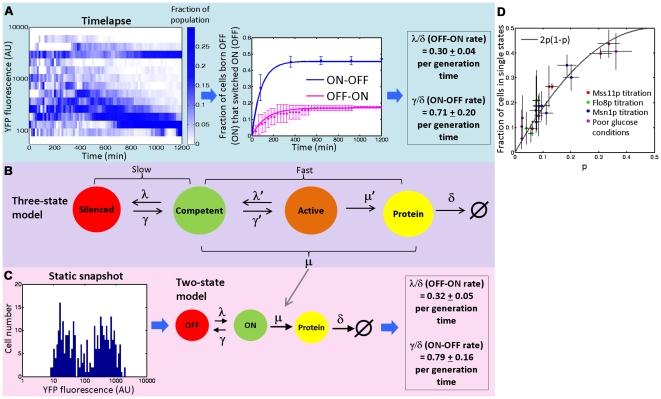
A method for inferring kinetics of switching from static steady state distribution.(A) (Left) Time evolution of the population distribution of YFP expression from a dual-reporter strain growing in YP 1% ethanol, 2% glycerol within a microfluidic chamber over 20 hours. Colorbar indicates fraction of cells (n = 230 over time course). This strain had been growing in identical conditions in liquid culture prior to transfer to the microfluidic chamber. The distribution changes early on because of the small initial sample size (n = 10). (Right) Marginal transition rates between ON and OFF states. Blue/pink dots indicate fraction of cells ON/OFF at birth and observed to switch OFF/ON. Corresponding curves are fits of the model for exponentially distributed switching times from ON to OFF and OFF to ON, with adjusted rates shown next to the plot. Error bars correspond to 3 s.d. from the mean calculated by a bootstrap analysis. Similar results are obtained when focusing on CFP expression (see Figure S5 and Figure S6). (B) Three-state model of FLO11 activation showing separation of timescales between epigenetic (silencing) and conventional regulation. When slow transitions associated with silencing are present, the fast transitions of transcriptional bursting can be lumped into a single rate μ. The model then collapses into the two-state model in (C). (C) (Left) Static distribution of YFP fluorescence of dual-reporter strain grown in identical media conditions as A but in deep well plates rather than the microfluidic device. Transition rates inferred from this snapshot using a stochastic kinetic model (right) agree closely with those obtained by timelapse microscopy. (D) Modulation of switching rates. The stochastic kinetic model's prediction of the fraction of cells in the mixed expression state corresponds to independent switching (given by 2p(1−p), corresponding to the gray line) for a range of conditions. Error bars (x-axis) are from 95% confidence intervals from MLE fit of switching rate to estimate true fraction of ON cells; error bars (y-axis) are due to errors in the estimation of threshold fluorescence value for autofluorescence (see Text S1).